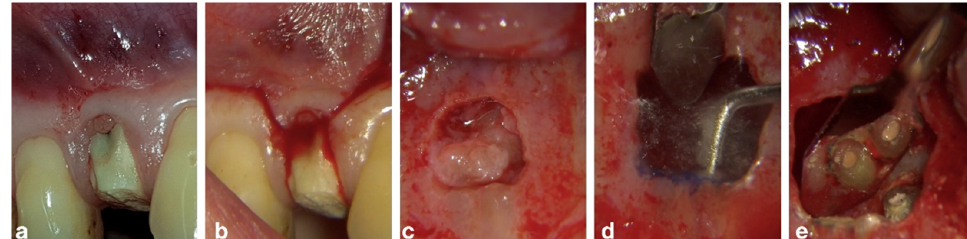
Figure 3. ( a ) Pre ‐ operative view of the premolar, ( b ) flap design, ( c ) intra ‐ operative view of the lesion, ( d ) ultrasonic tip in action, ( e ) intra ‐ operative view of the retrograde obturation.